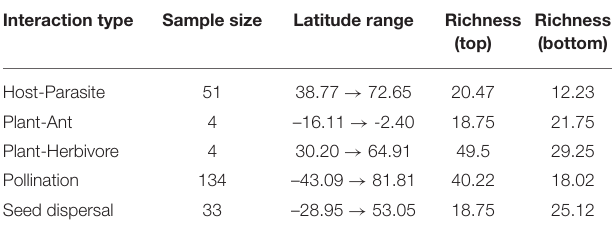
TABLE 1 | Overview of the web-of-life.es